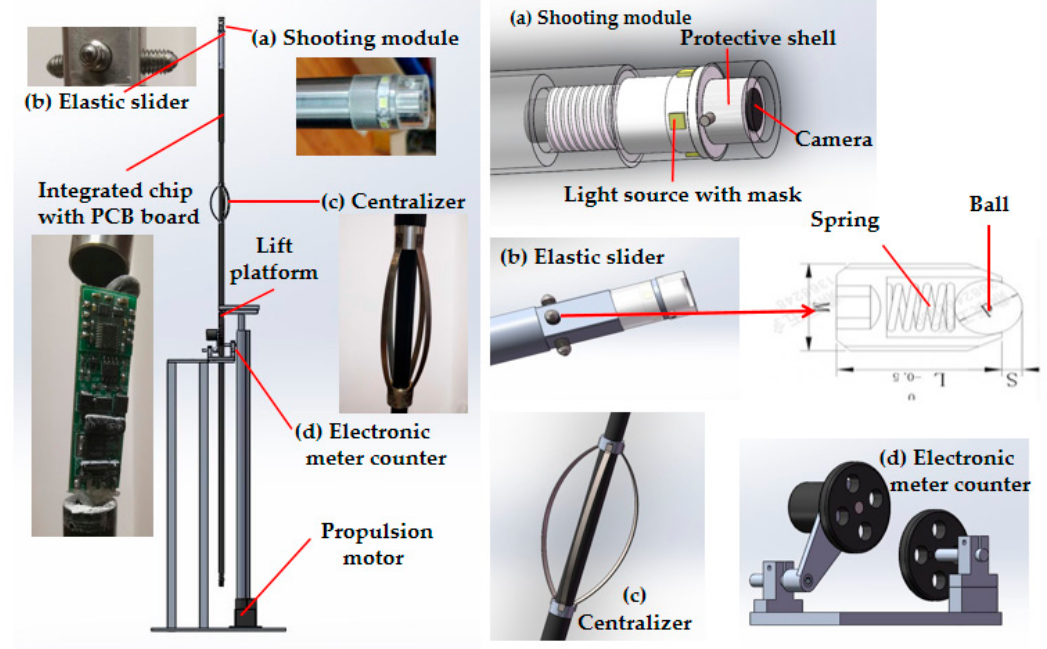
Figure 1. System partial function introduction.